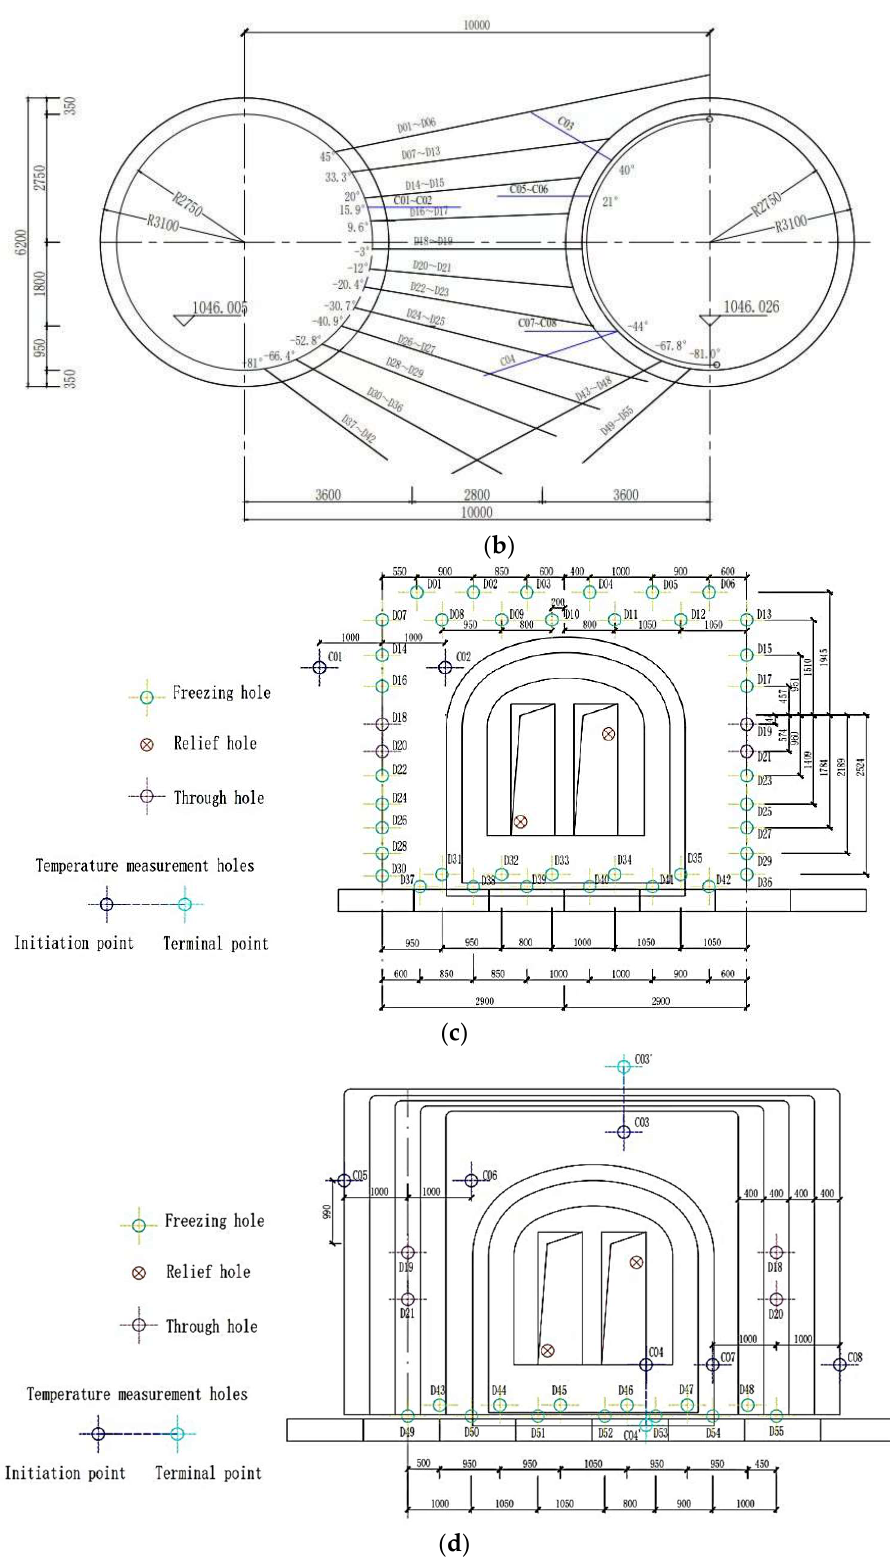
Figure 1. Freeze tube and left and right line tunnel borehole layout of the No. 2 contact channel. ( a ) Geological stratigraphy, ( b ) section of the freeze hole arrangement, ( c ) plan of the freezing hole on the side of the freezing station, and ( d ) plan of the freezing hole on the opposite side of the freezing station.